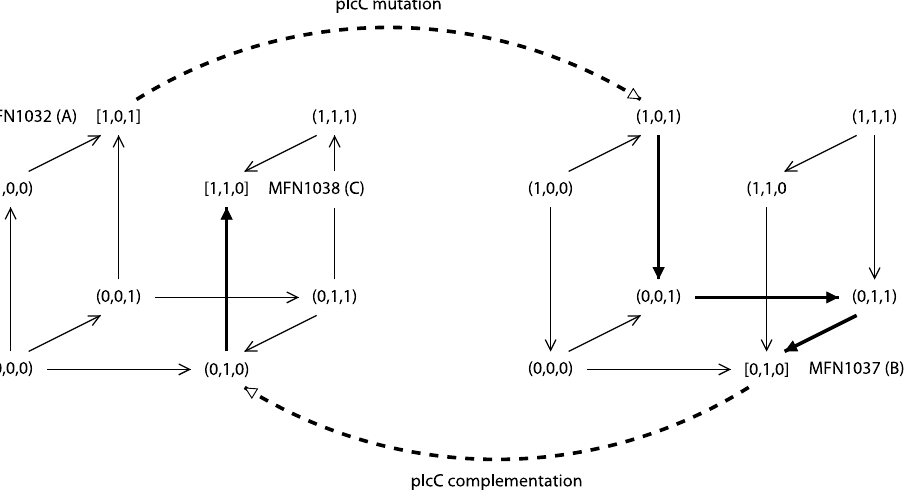
Figure 2. Illustration of property P on network 1. Asynchronous state graphs are represented in a grid, as in Figure 1. The left graph described the dynamics of network 1. The right graph described the dynamics of network 1 under plcC mutation. Stable states A , B and C correspond to strains MFN1032, MFN1037 and MFN 1038, respectively. Dotted arrows represent the effect of mutation or complementation in plcC . Bold lines represent trajectories followed by the systems.